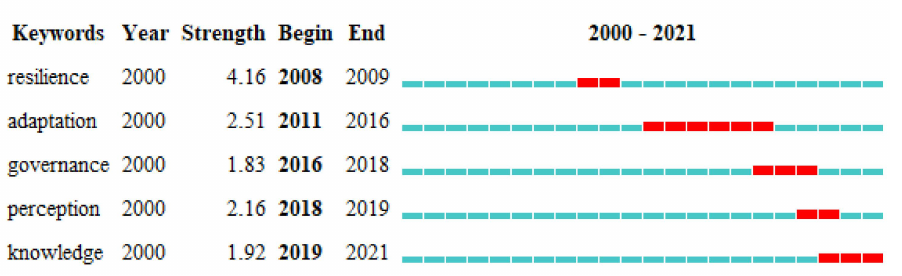
Figure 5. Top five keywords with the strongest citation